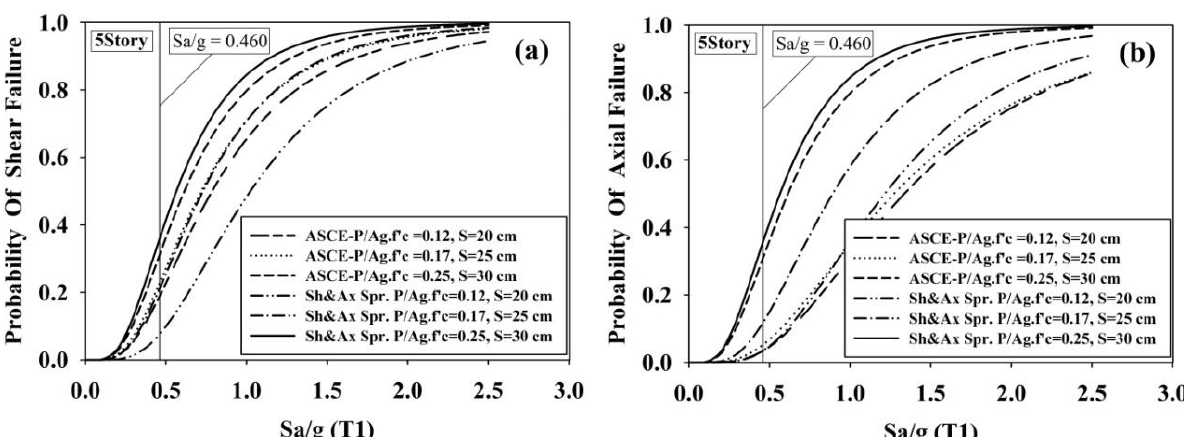
Fig. 15. Seismic fragility curve of shear and axial failure for 5-story models, (a) probability first shear failure, (b) probability first axial failure.